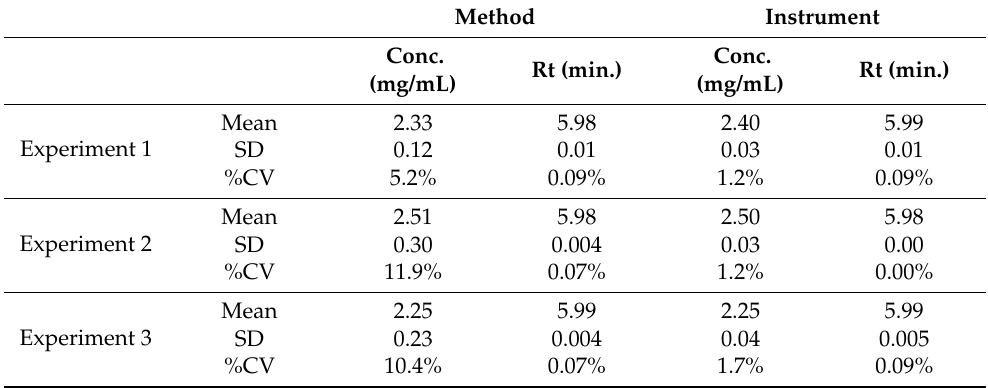
Table 2. Repeatability